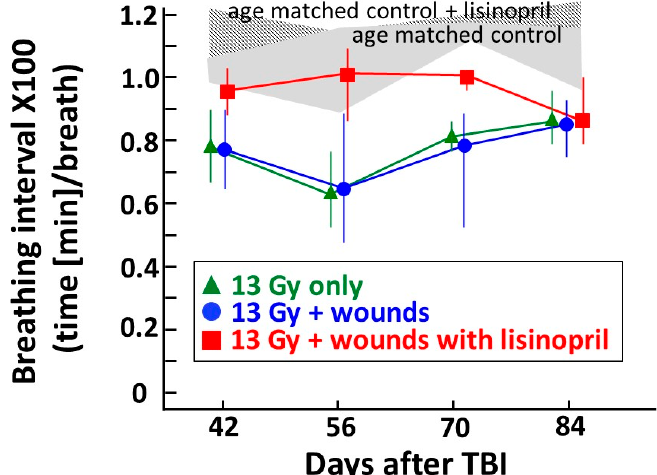
Figure 5. Graphical representation of breathing interval as a secondary and functional endpoint of pneumonitis, between 42 and 84 days post 13 Gy leg-out PBI with or without wound trauma. Non-irradiated, wounded rats (age matched control) or those given lisinopril (age matched control + lisinopril) have breathing intervals as shown in the shaded areas, which are similar to historical data from other studies with the same strain and sex [15]. The lines connect the median with 20–80% confidence intervals of the breathing intervals after 13 Gy leg-out PBI with or without wound trauma and also 13 Gy leg-out PBI + wounds with lisinopril started after 7 days and continued (see Materials and Methods for details). Rats morbid with lung injury confirmed at necropsy are given a breathing interval of 0 at all following time points to account for attrition. p ≤ 0.05 between the 13 Gy leg-out PBI + wounds vs. 13 Gy leg-out PBI + wounds + lisinopril groups at 42, 56 and 70 but not 84 days. Results show mitigation of radiation pneumonitis by lisinopril after irradiation only or after combined irradiation with skin wounds. N = 4–6/group for wounded, age-matched nonirradiated control groups; N = 8–12/group for irradiated groups.